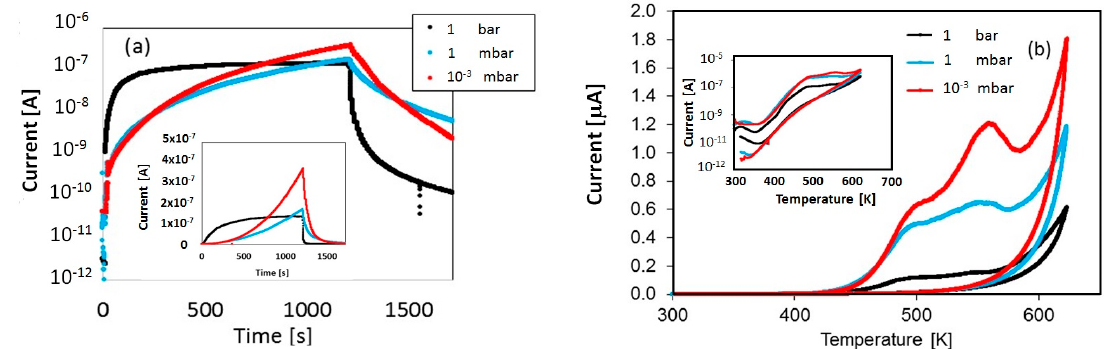
Figure 10. ( a ) Photocurrent measured during priming by illuminating with a Xe lamp the nc-TiO 2 sample in an He atmosphere of different pressures at T = 300 K; ( b ) TSC measured after priming with 1 bar,1 mbar, 10 − 3 mbar. Heating/cooling cycles are performed in He atmosphere with 1 bar pressure.